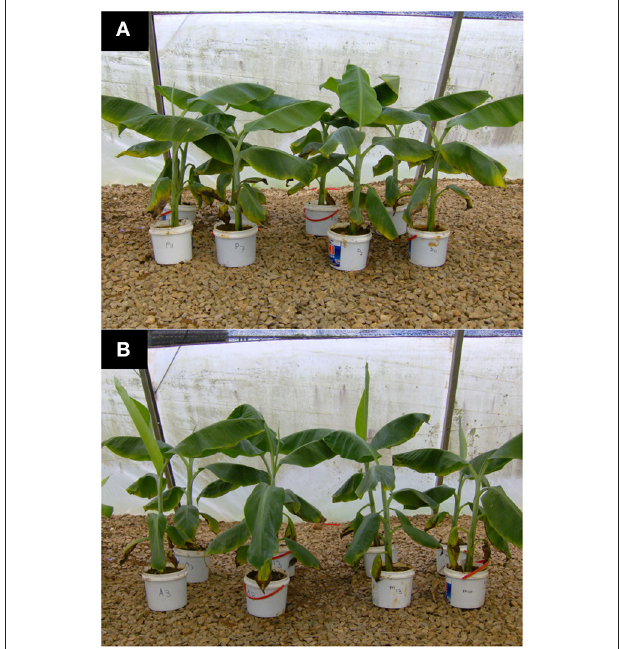
FIGURE 4 | Tissue culture banana plants grown in potted sterile soil and supplied with completer nutrient solution. (A) Control plants (Left pots labeled P) and those inoculated with Fusarium oxysporum V5w2 (Right pots labeled D) all having been grown in sterile soil. (B) Plants co-inoculated with Radopholus similis and Fusarium oxysporum V5w2 (Left pots labeled A) and those inoculated with Fusarium oxysporum V5w2 only (Right pots labeled M) all having been grown in sterile soil. Leaf margins of all banana plants grown in sterile soil developed a characteristic yellow coloration especially from the older lower leaves toward the upper second youngest open